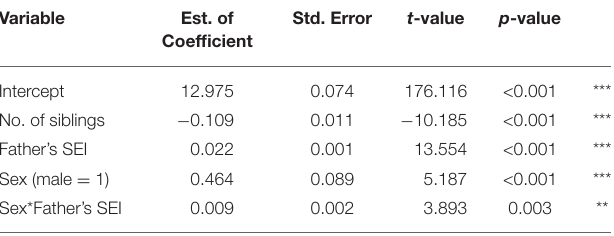
TABLE 4 | Effect of father’s SEI on respondent’s educational attainment.